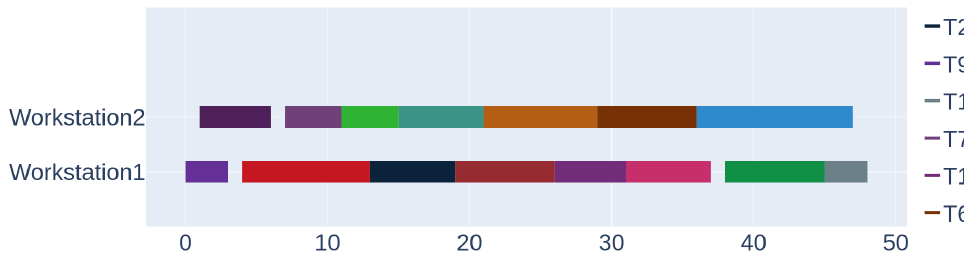
Figure 11. Scenario 2: Tasks’ assignment—trained